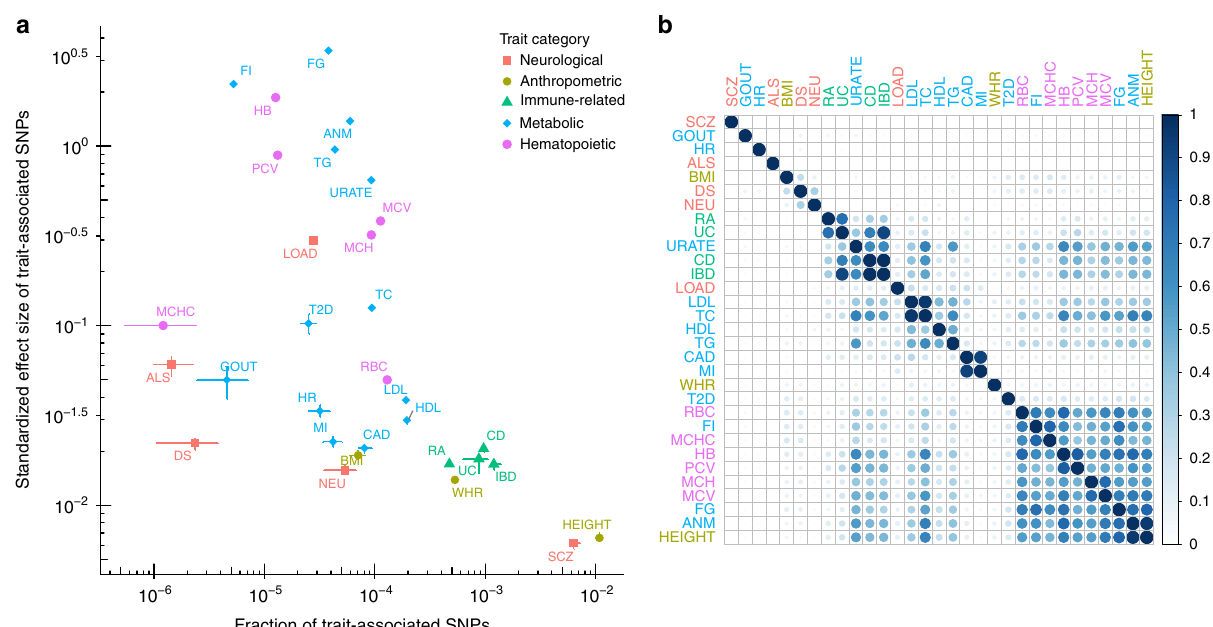
Fig. 4 Baseline and enrichment analyses of GWAS summary statistics for 31 complex traits. References of these data are provided in Supplementary Notes. a Summary of inferred effect size distributions of 31 traits. Results are from fi tting the baseline model ( M 0 ) to GWAS summary statistics of 1.1 million common HapMap3 SNPs for each trait using variational inference (Methods). We summarize effect size distribution using two statistics: the estimated fraction of trait-associated SNPs (average posterior probability of a SNP being trait-associated; x -axis) and the standardized effect size of trait-associated SNPs (average posterior mean effect size of all SNPs, normalized by phenotypic standard deviation and fraction of trait-associated SNPs; y -axis). Each dot represents a trait, with horizontal and vertical point ranges indicating posterior mean and 95% credible interval. See Supplementary Notes for more details. Note that some intervals are too small to be visible due to log10 scales. See Supplementary Table 2 for numerical values of all intervals. b Pairwise sharing of 3913 pathway enrichments among 31 traits. For each pair of traits, we estimate the proportion of pathways that are enriched in both traits, among pathways enriched in at least one of the traits (Methods). Traits are clustered by hierarchical clustering as implemented in the package corrplot (Methods). Darker color and larger shape represent higher sharing. The sharing estimates are provided in Supplementary Table 3. ALS amyotrophic lateral sclerosis; DS depressive symptoms; LOAD late-onset Alzheimer ’ s disease; NEU neuroticism; SCZ schizophrenia; BMI body mass index; HEIGHT adult height; WHR waist-to-hip ratio; CD Crohn ’ s disease; IBD in fl ammatory bowel disease; RA rheumatoid arthritis; UC ulcerative colitis; ANM age at natural menopause; CAD coronary artery disease; FG fasting glucose; FI fasting insulin; GOUT gout; HDL high-density lipoprotein; HR heart rate; LDL low-density lipoprotein; MI myocardial infarction; T2D type 2 diabetes; TC total cholesterol; TG triglycerides; URATE serum urate; HB hemoglobin; MCH mean cell HB; MCHC MCH concentration; MCV mean cell volume; PCV packed cell volume; RBC red blood cell